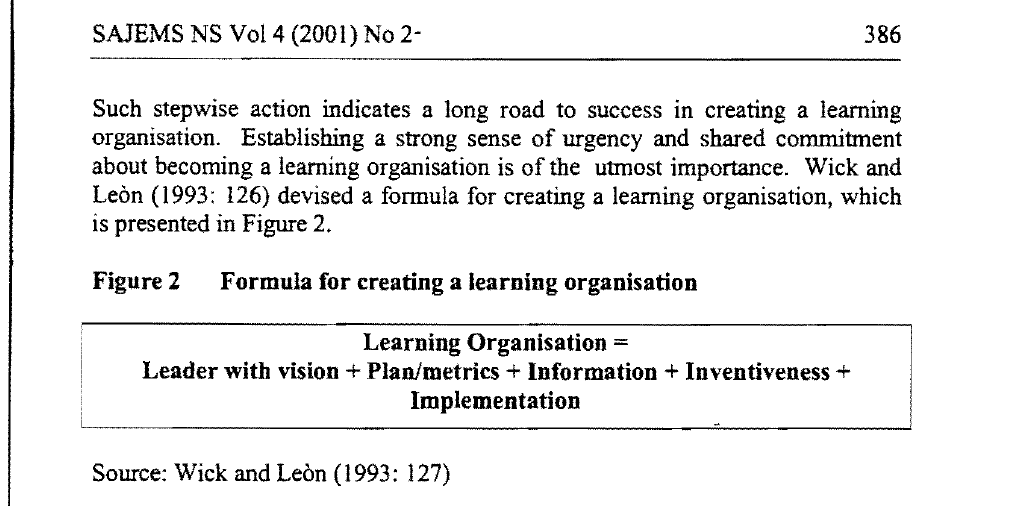
Formula for creating a learning organisation Learning Organisation =